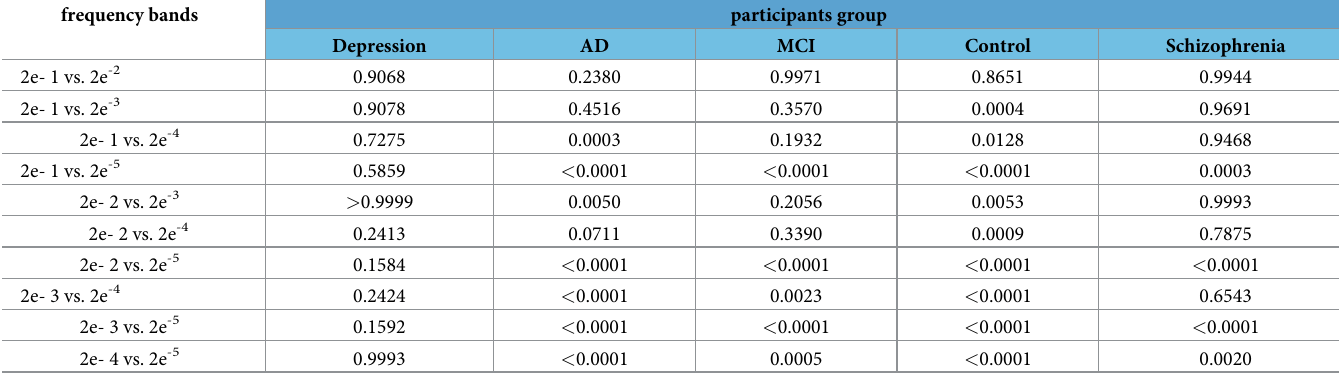
Table 7. Intragroup comparison of QP power spectrum frequencies of QP electrode values.